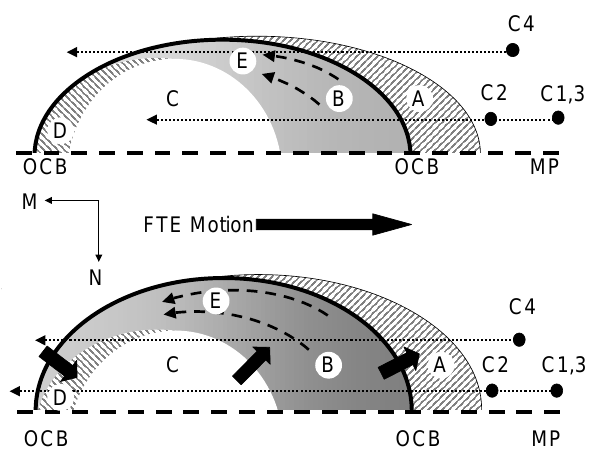
Fig. 9. A possible interpretation of the PEACE observations for the internal structure of FTEs. In each panel, the FTE is assumed to be a bundle of reconnected flux tubes occupying the region between the unperturbed magnetopause (dashed horizontal line marked MP) and an internal boundary between the open and closed flux tubes (represented by the curved solid line marked OCB at each end). The relative trajectories of the 4 spacecraft are represented by the horizontal dotted arrowed lines, which point left as the FTE motion is in the negative M direction, i.e. to the right. The observation of enhanced field strengths and densities of magnetospheric electrons prior to the arrival of the magnetosheath electrons implies a com- pressed region (marked A) on the closed flux tubes ahead of the FTE. On crossing the OCB, the spacecraft will observe a sudden enhancement of magnetosheath electrons on the oldest reconnected field lines (marked B). On moving further into the FTE, the space- craft move onto more recently reconnected field lines, which may not yet have completely filled with magnetosheath plasma, and thus observe a declining density (marked C). It appears that an enhance- ment in magnetospheric electrons occurs in the trailing edge of the FTE (marked D). In order to explain the delayed and extended sig- nature at C4, it is necessary to account for magnetosheath electrons in the region marked E in the figures. We infer a re-circulation of the oldest reconnected flux tubes along the leading edge of the FTE structure, as indicated by the dashed arrowed lines. During the first event, represented by the upper figure, we suggest that C4 passes through this region, then out across the OCB and back onto closed field lines and thus does not observe the magnetospheric population marked D. During the second event studied in this paper, repre- sented in the lower figure, we infer that C4 passed relatively deeper into the FTE, and that the re-circulation of the oldest flux tubes had proceeded sufficiently to push some of these flux tubes as far back as the trailing edge of the FTE. Therefore, all 4 spacecraft observe a second enhancement of magnetosheath electrons after the magneto- spheric population (D). In addition, this interpretation is consistent with the inferred motion of the 4 boundaries shown in Fig. 8, as indicated by the heavy arrows in the lower